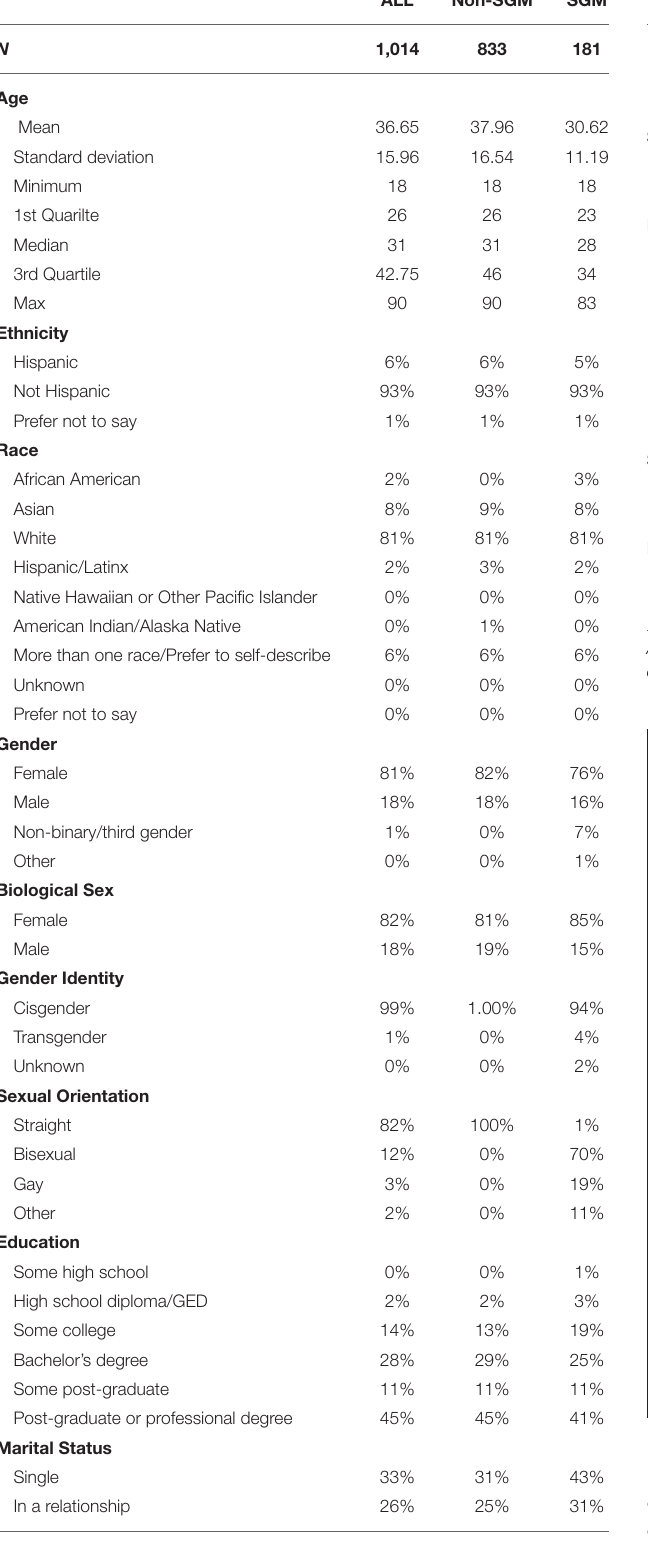
calculated and added to the models to determine the impact of perceived social isolation (Model 2) and virtual socialization (Model 3) on the relationship between SGM status and time